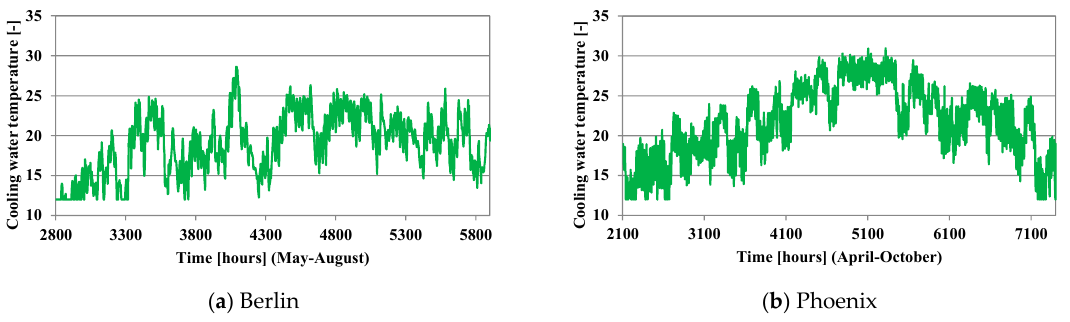
Figure 14. The variation of the cooling water temperature for two locations.